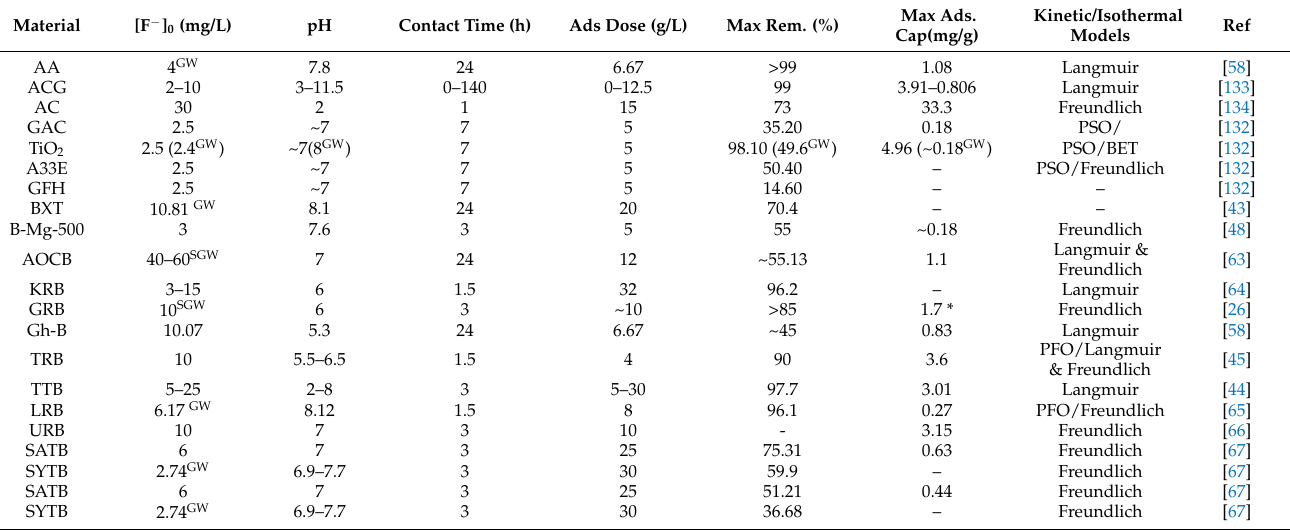
Table 4. Comparative evaluation of selected bauxite adsorbents and AA used for F − removal from